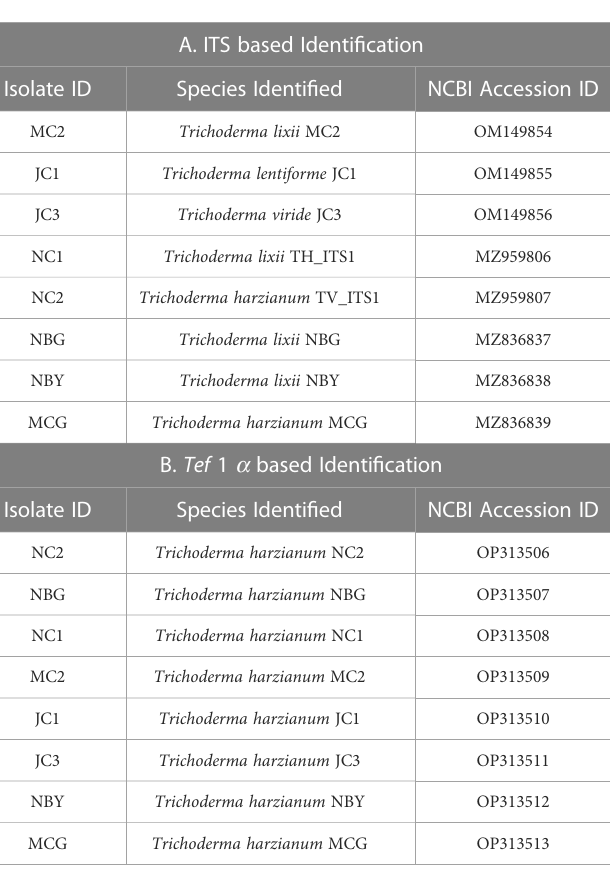
TABLE 2 Molecular identi fi cation of ITS and tef 1 a based molecular